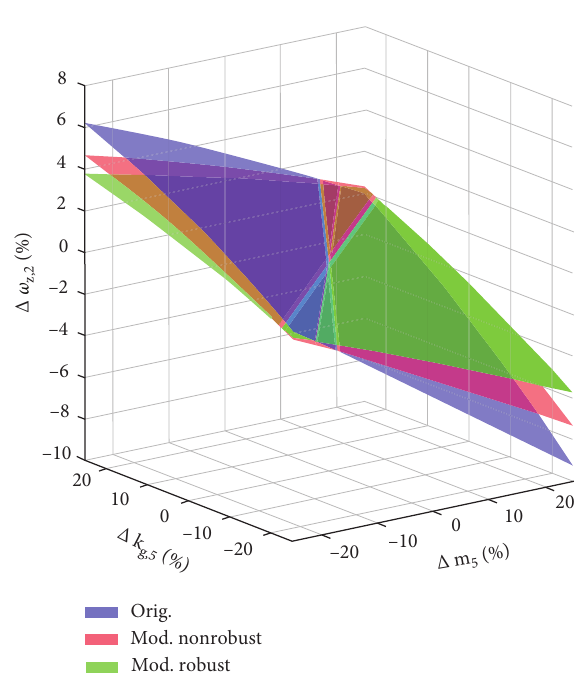
Figure 6: Test-case 2: percentage variation of the second anti- resonance frequency in the original and modified